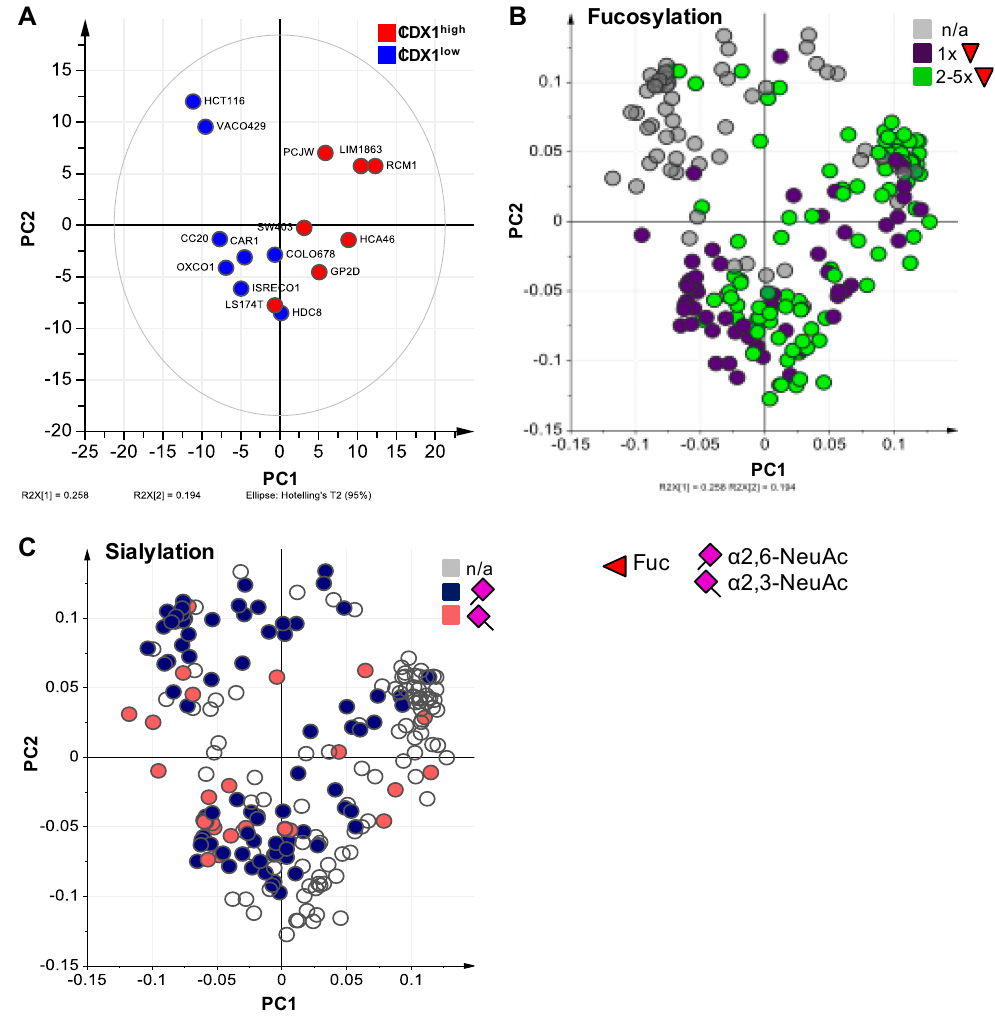
Figure 3. Principle component analysis of N -glycomic profiles. Principle component analysis (PCA) was performed to explore differences in N -glycosylation between CDX1-high and CDX1-low expressing cells. ( A ) Score plot of principal components (PC) 1 vs. 2 explaining 25.8% and 19.4% of the data, respectively. ( B ) Corresponding loading plot with color indications for multi- (green) and mono-fucosylated (purple) individual N -glycans, and ( C ) the same loading plot with color indications for α 2,3-sialylated (rose) and α 2,6-sialylated (blue) N -glycans. Red triangle = fucose, Fuc; purple diamond = sialic acid, N -acetylneuraminic acid, NeuAc. Differences in N -acetylneuraminic acid linkages are indicated using different